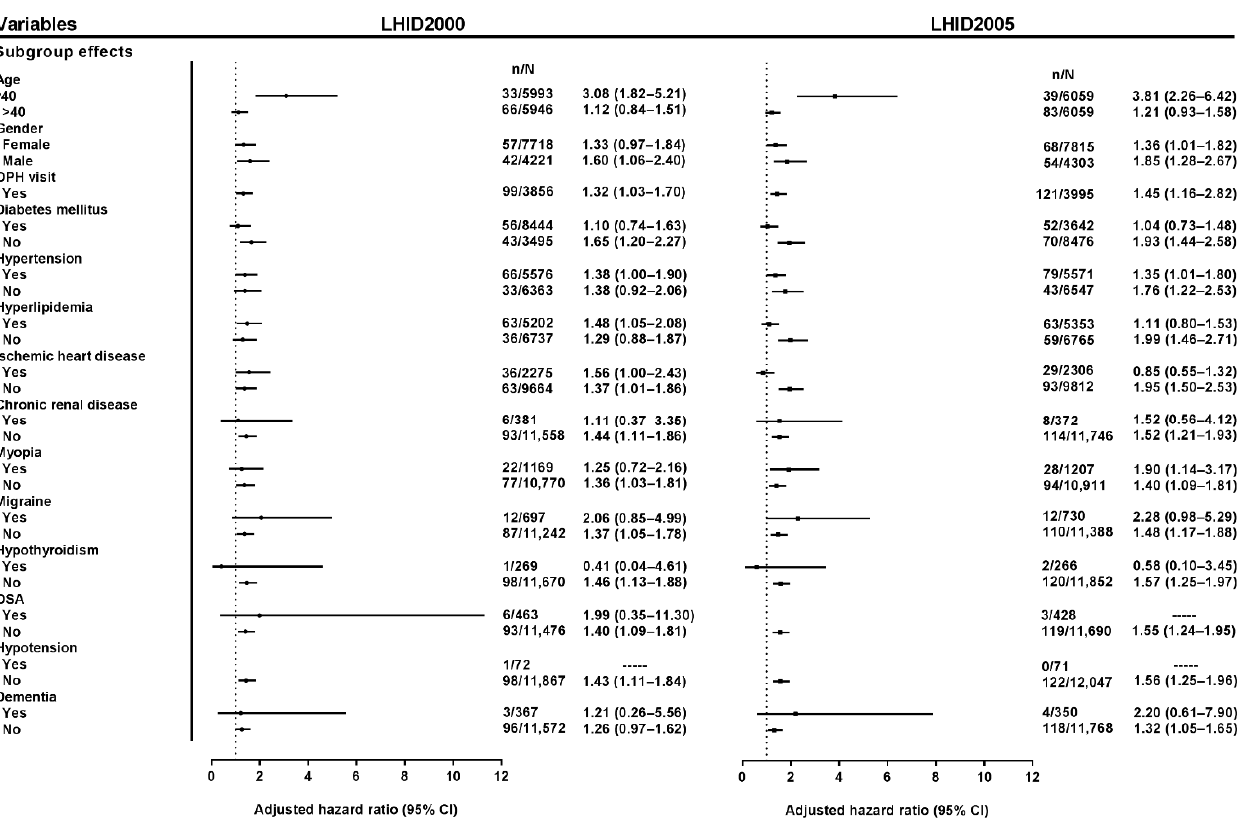
Figure 4. Multivariable stratified hazard analysis of the association between obesity and open-angle glaucoma. All adjusted hazard ratios in the multivariable stratified analysis were adjusted by the main model. The results in both the LHID2000 and LHID2005 displayed that obesity was a remarkable hazard of OAG in young (aged ≤ 40 years) obese adults compared with young non-obese adults. In gender stratification, the risk of OAG was more significant in obese men than non-obese men. As for the stratified analysis of covariates, in the LHID2005, the obese group without each covariate had an increased risk of OAG compared with the non-obese group without each covariate; however, the obese group with each covariate had a nonsignificant risk of OAG compared with the non-obese group with each covariate. There was a similar tendency in most of the stratified analyses of covariates in the LHID2000, but the analyses of hypertension and hyperlipidemia were inconsistent between the LHID2000 and LHID2005. There was no adjusted hazard ratio in a few subgroups (obesity with OSA in the LHID2005, and obesity with hypotension in both the LHID2000 and LHID2005). LHID = longitudinal health insurance database; OAG = open-angle glaucoma; OSA = obstructive sleep apnea; OPH =